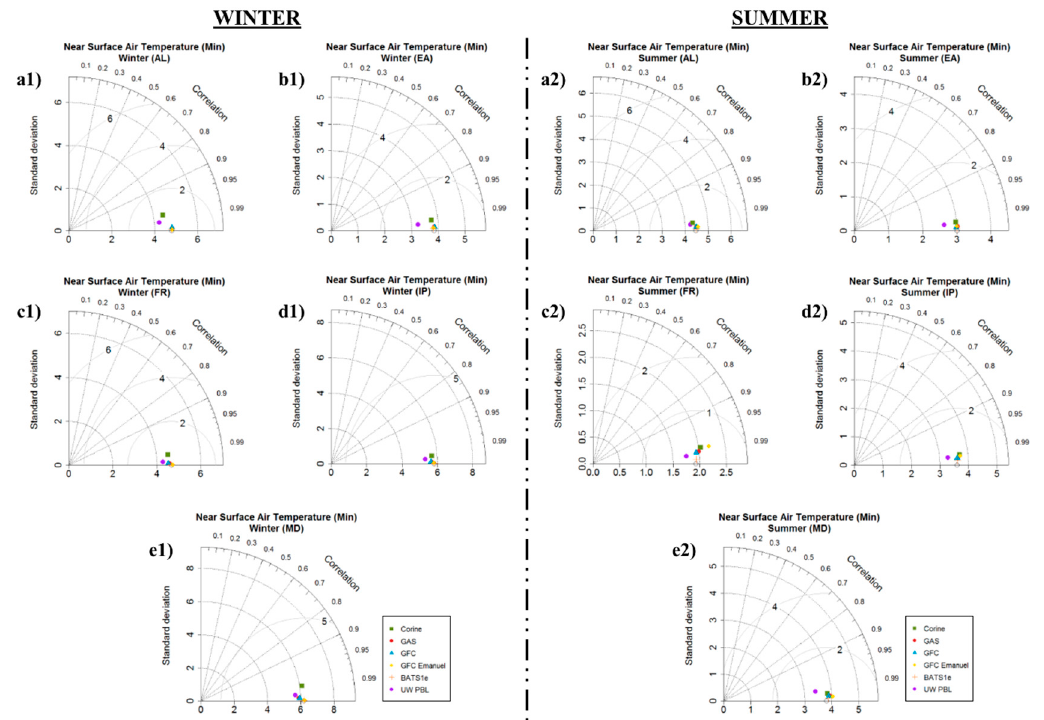
Figure 8. Taylor diagrams exploring the model’s performance for near surface min temperature over the five sub-regions (a → AL, b → EA, c → FR, d → IP, e → MD) during winter and summer. The markers in